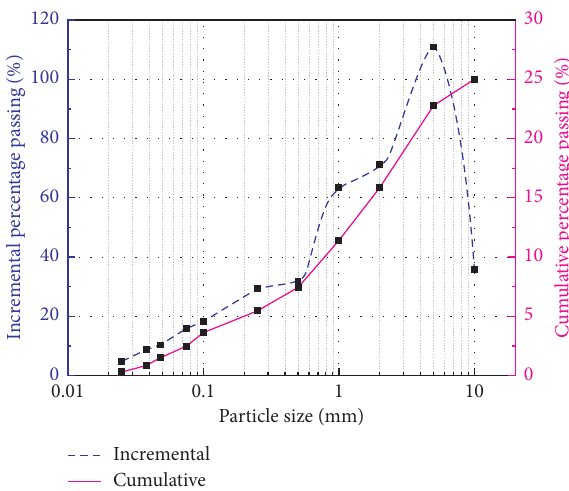
Figure 2: Particle size distribution of the ion-adsorption rare earth